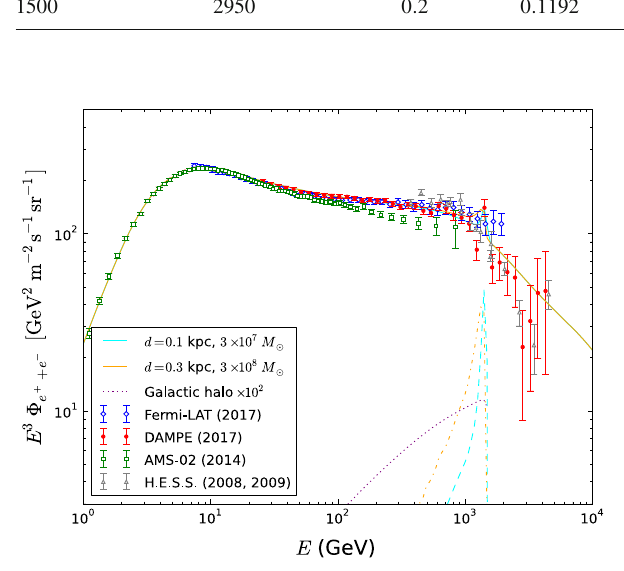
Fig. 4 The e + + e − flux for our benchmark point. The DAMPE data is shown in red points. The blue dotted line corresponds to Galactic halo contribution (multiplied by 10 2 ), and cyan dashed (orange dot-dashed) linecorrespondstocontributionofnearbysubhalowithadistanceof0 . 1 (0 . 3)kpcandtheviralmass3 × 10 7 M (cid:18) (3 × 10 8 M (cid:18) )[24].Correspond- ing total fluxes (background + Galactic halo + subhalo) are also shown by solid lines with the same colors. Here we take solar modulation potential as (cid:5) (cid:18) = 700 MV for illustration. For comparison, the direct measurements from AMS-02 [89] and Fermi-LAT [90] experiments, as well as the indirect measurement by [91,92] are also shown. The error bars of DAMPE, AMS-02 and Fermi-LAT include both systematic and statistical